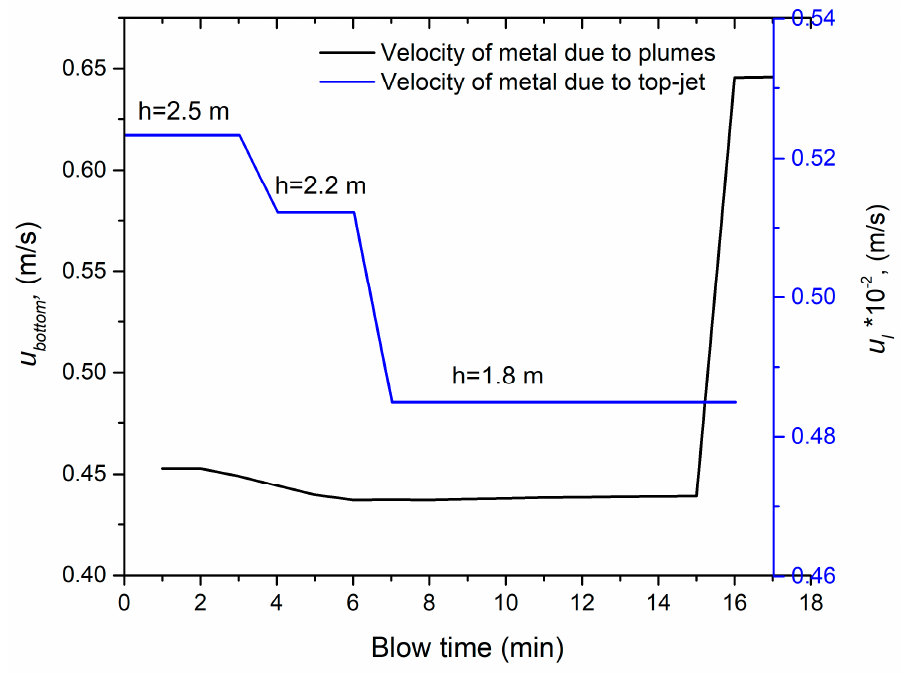
Figure 5. Comparison of surface renewal velocities due to top-jet and bottom stirring, (h = lance height, m).